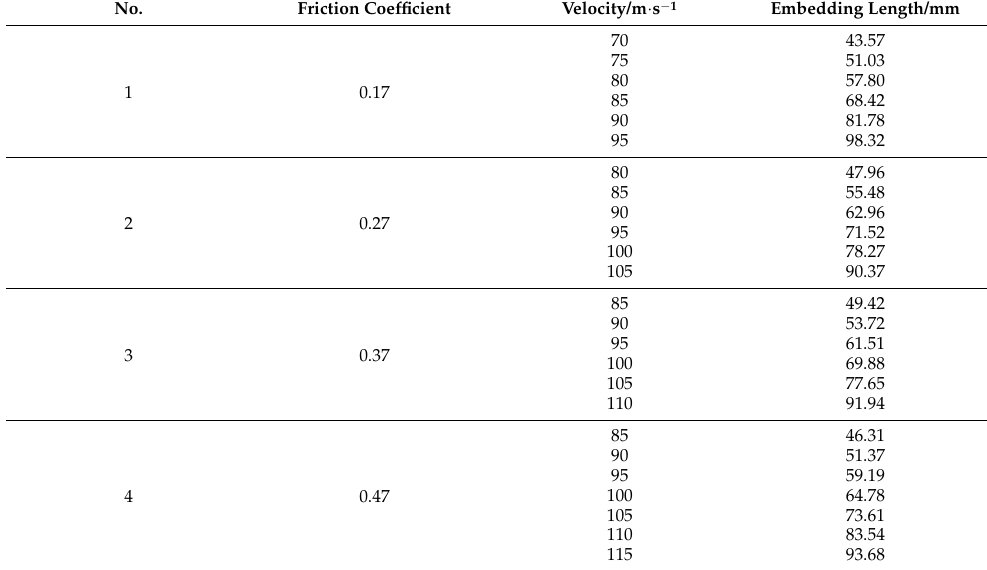
Table 5. Harpoon embedding